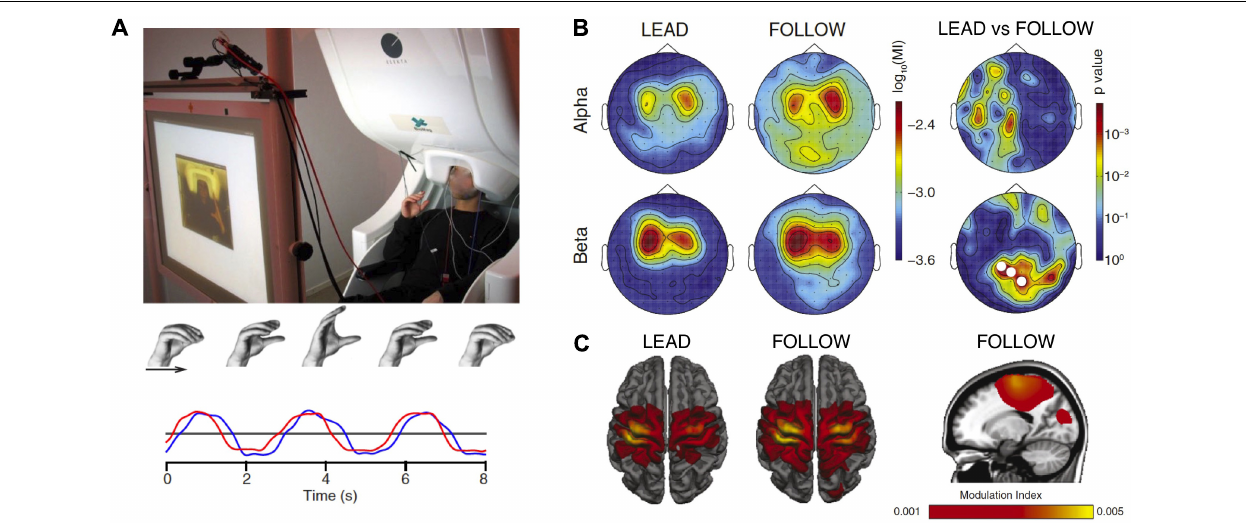
FIGURE 4 | Modulation of brain signals by joint action. (A) Experimental setup. Participants were seated in two separate MEG systems and instructed to perform rhythmic precision-grip-like movements in synchrony with their partner, either leading or following the other’s movement. Example movement traces (red, blue) are shown at the bottom, indicating similar movement with slight delay between the participants. (B) Modulation of alpha- and beta-band power by the phase of the hand movement in the two conditions. Modulations occurred over central areas and, for beta power, also over visual cortex. Significant differences between the leader and follower conditions (right) occurred only for beta-band power recorded from visual areas. This role-specific modulation of brain activity might be reflecting the need for the follower to coordinate own proprioceptive signals with the visual feedback about the movement of the leading participant. (C) Source space projection of the results shown in panel (B) . Power modulations are observed in sensorimotor cortex as well as, in the follower condition, in visual cortex. Modified from Zhou et al.